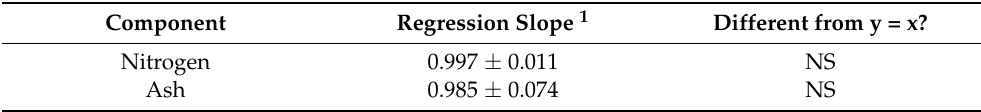
Table 3. Regression relationship for concentrations of various components dosed twice a day in rectal grab samples of faeces (y) from grazing sheep in relation to the concentrations in total faeces